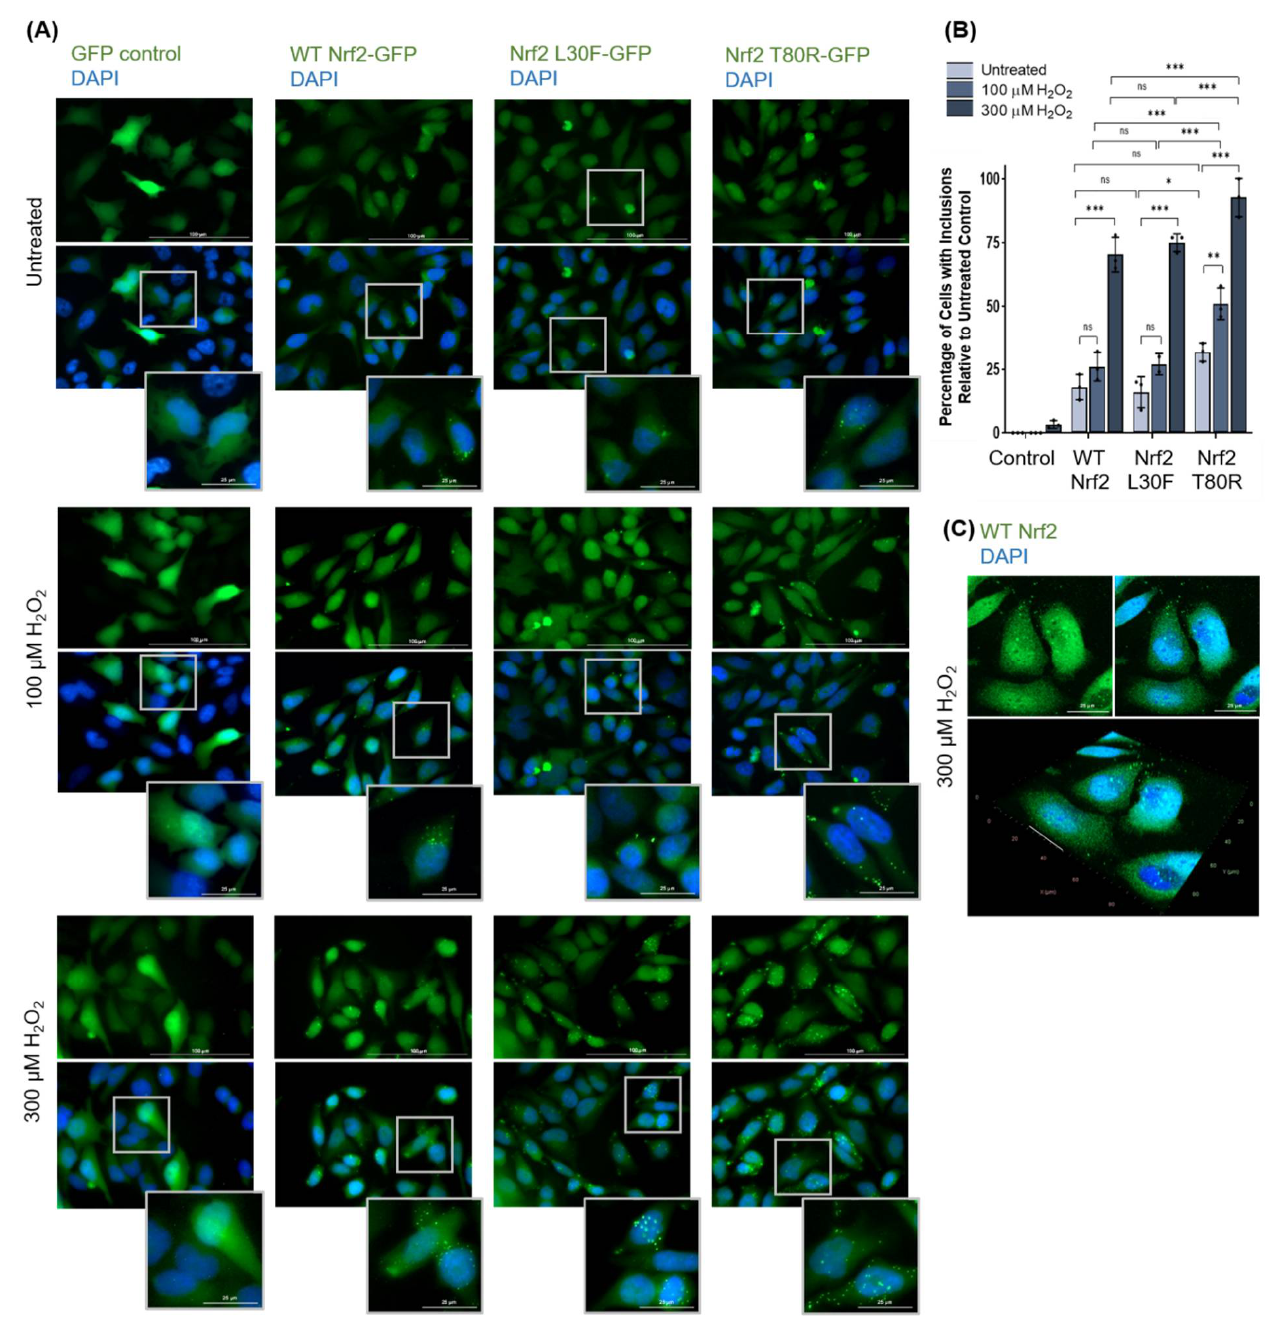
Figure 3. Nrf2 forms inclusions upon exposure to high levels of oxidative stress in HeLa